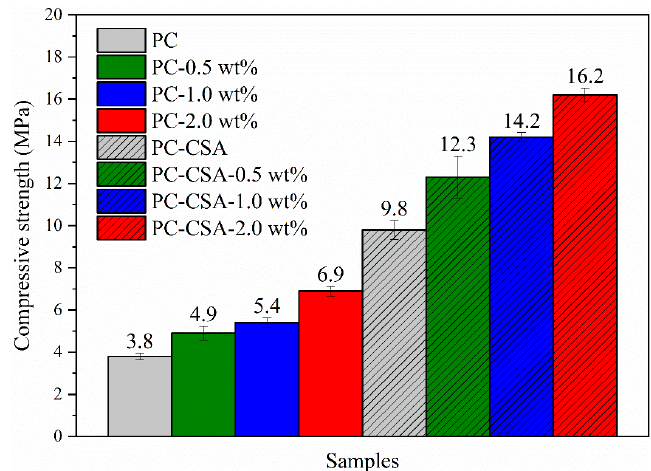
Figure 4. The 10 h compressive strength of different samples.